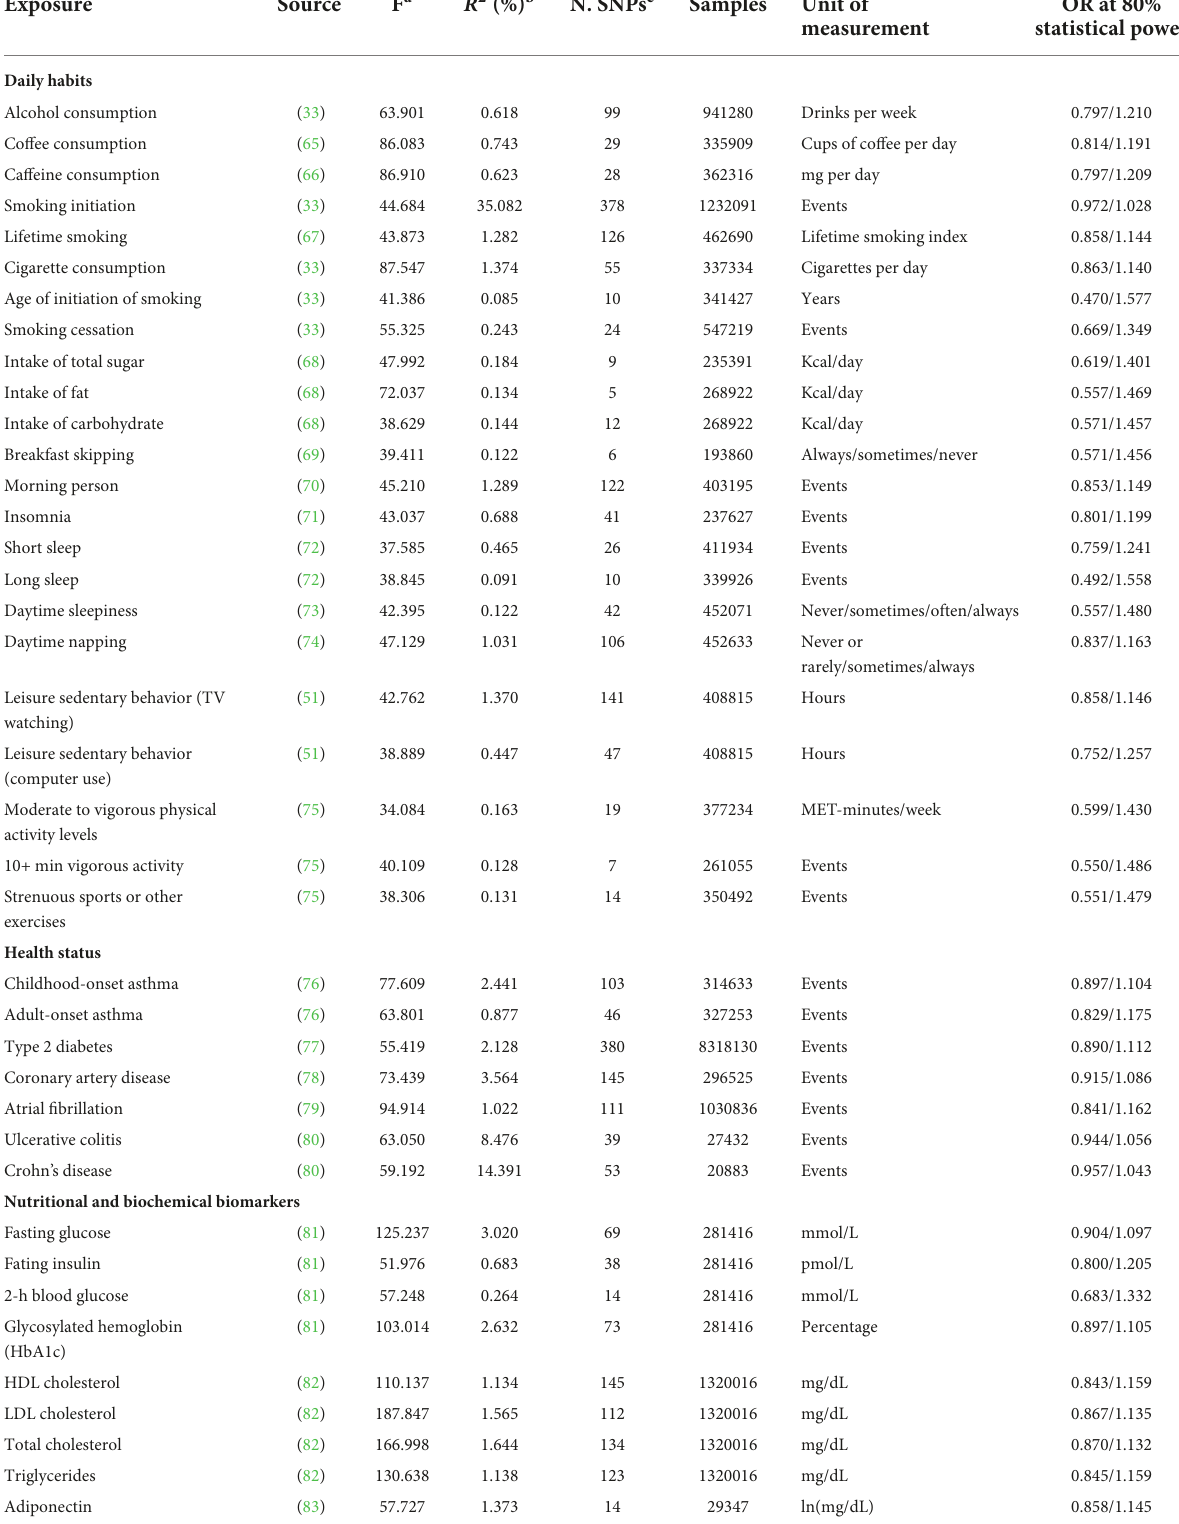
TABLE 1 Information of the 66 exposures included in MR